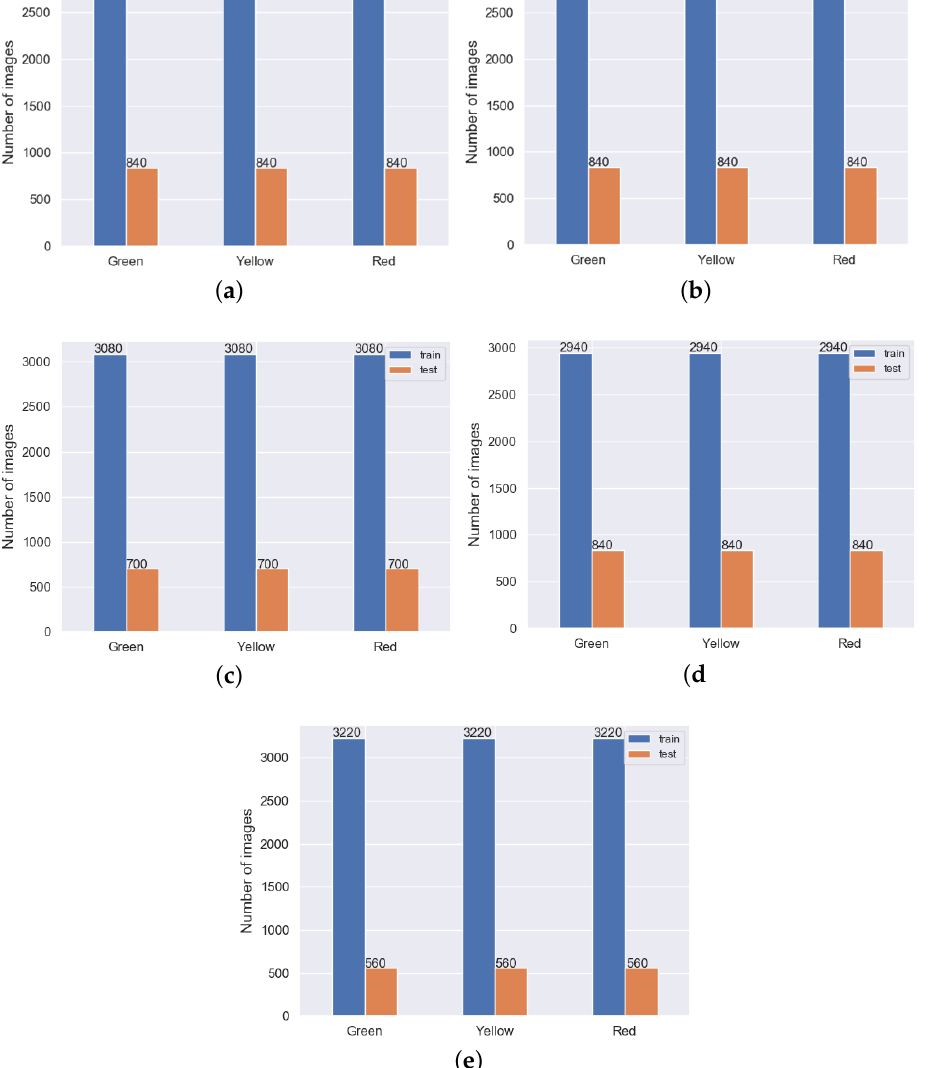
Figure 4. Fold data split during the training process using 5-fold cross-validation. The subsequent images represent the structure of: Fold 1 ( a ), Fold 2 ( b ), Fold 3 ( c ), Fold 4 ( d ), Fold 5 ( e